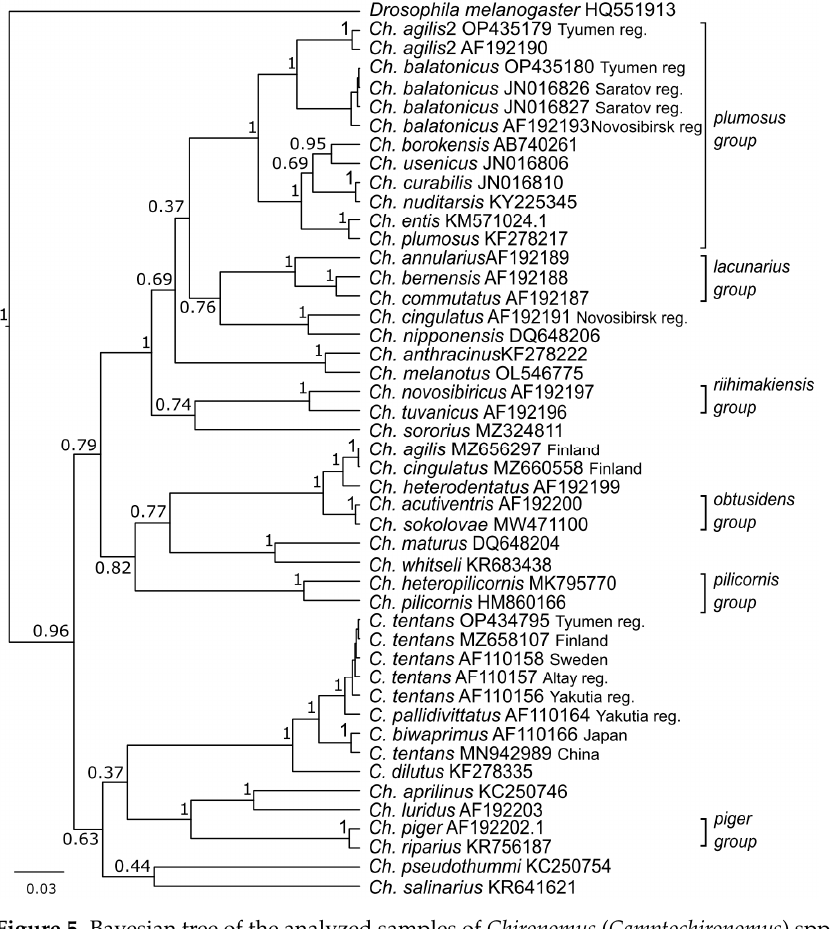
Figure 5. Bayesian tree of the analyzed samples of Chironomus ( Camptochironomus ) spp., inferred from COI gene sequences. Species name. GenBank accession numbers and group name are shown to the right of the branches. Support p ‐ values are given if they exceed 0.3.